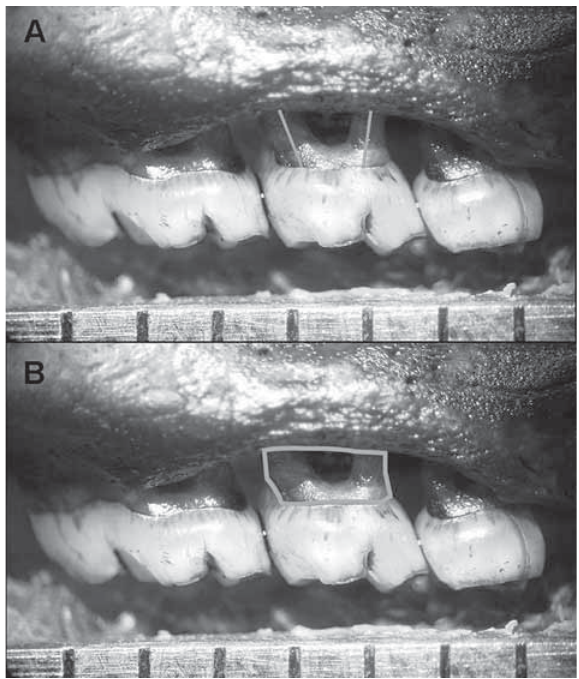
Figure 1- Photograph of alveolar bone loss evaluated morphometrically by measuring the linear distance between the cementoenamel junction and alveolar